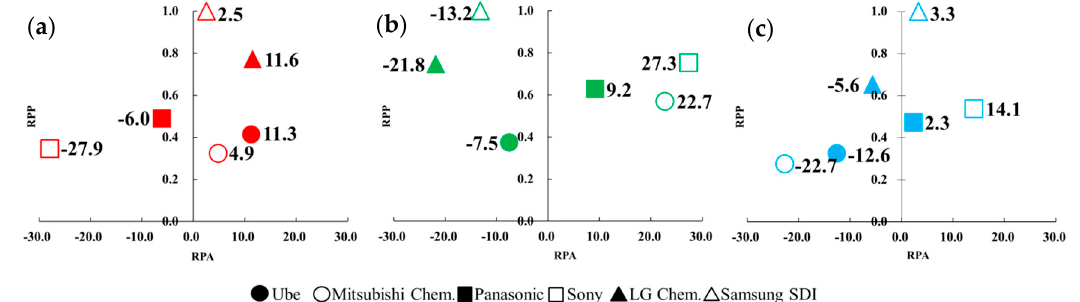
Figure 2. Revealed patent advantage (RPA) and relative patent position (RPP) analysis of six companies based on three technological fields: ( a ) H01M10 / 0567 (additives), ( b ) H01M10 / 0568 (lithium salts), and ( c ) H01M10 / 0569 (solvents). For the purpose of clarity, only their RPA values were noted for easier comparison.